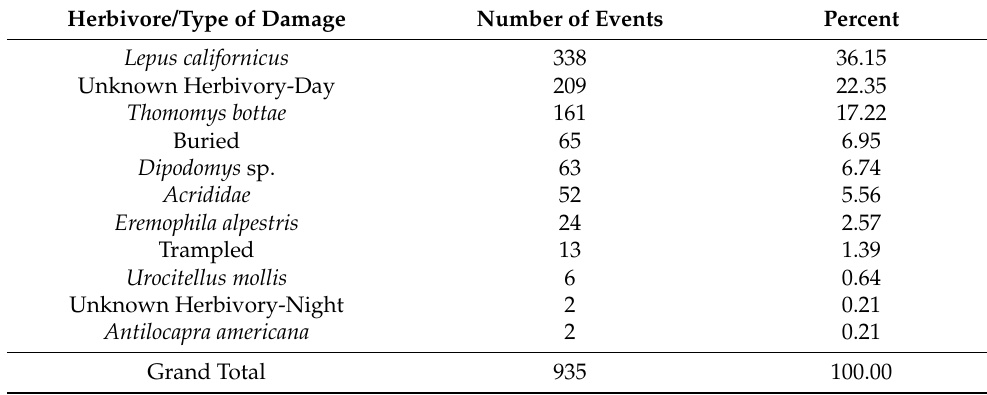
Table 3. Frequency and percent of herbivory events on seedlings separated by herbivore event types.